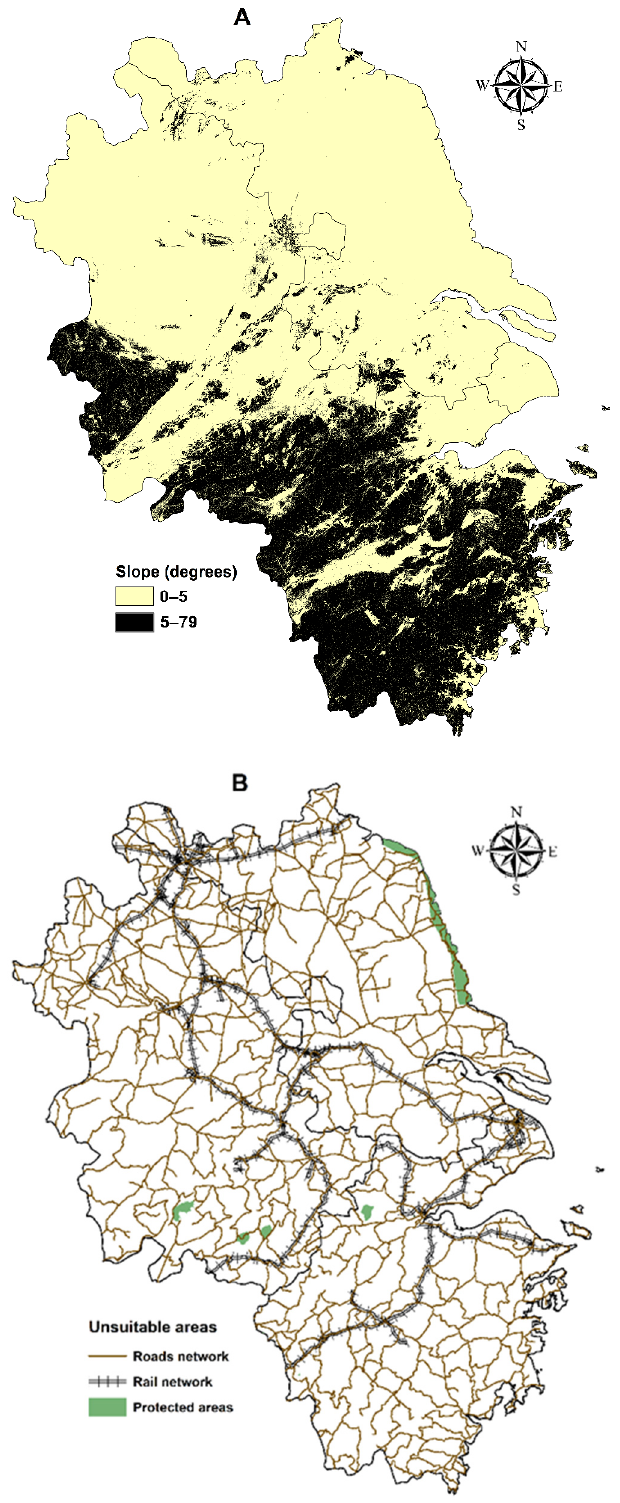
Figure 3. Yangtze River Delta Region: ( A ) reclassified slope and ( B ) road, rail network and protected areas